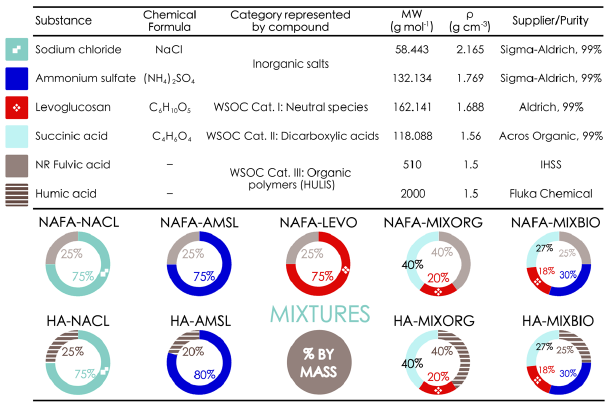
Fig. 1. Substances chosen as model compounds, their properties and mixtures of these substances studied in this